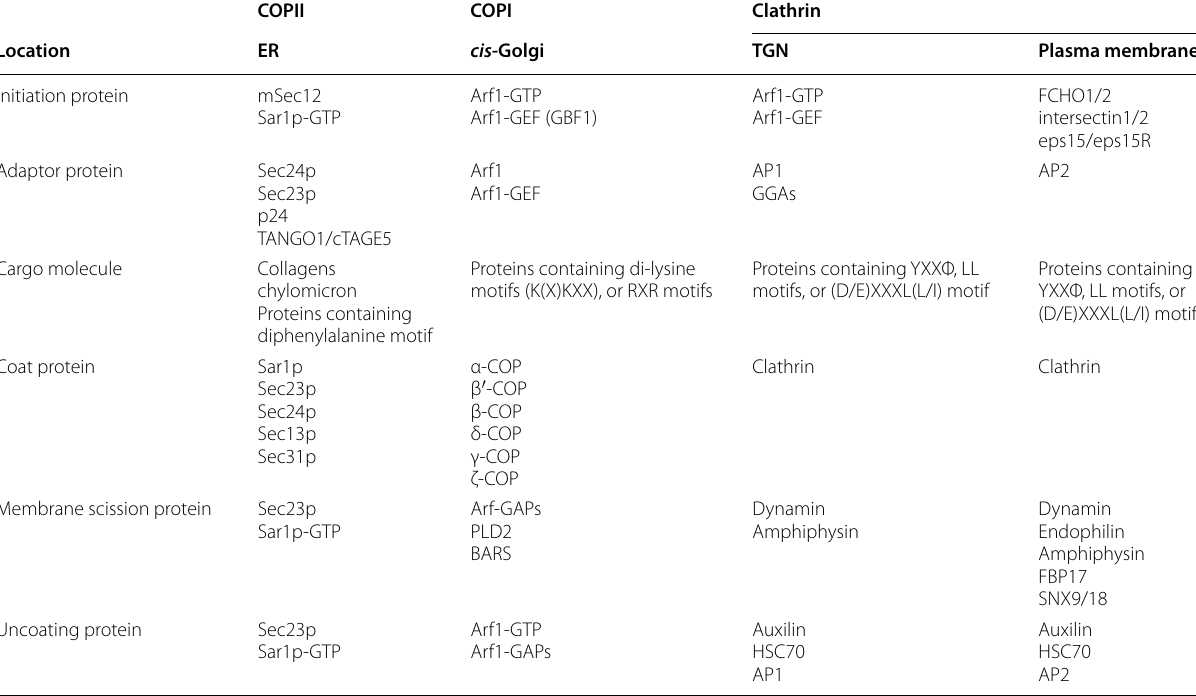
Table 1 Classic proteins involved in COPII-, COPI-, and clathrin-mediated vesicle formation COPII COPI